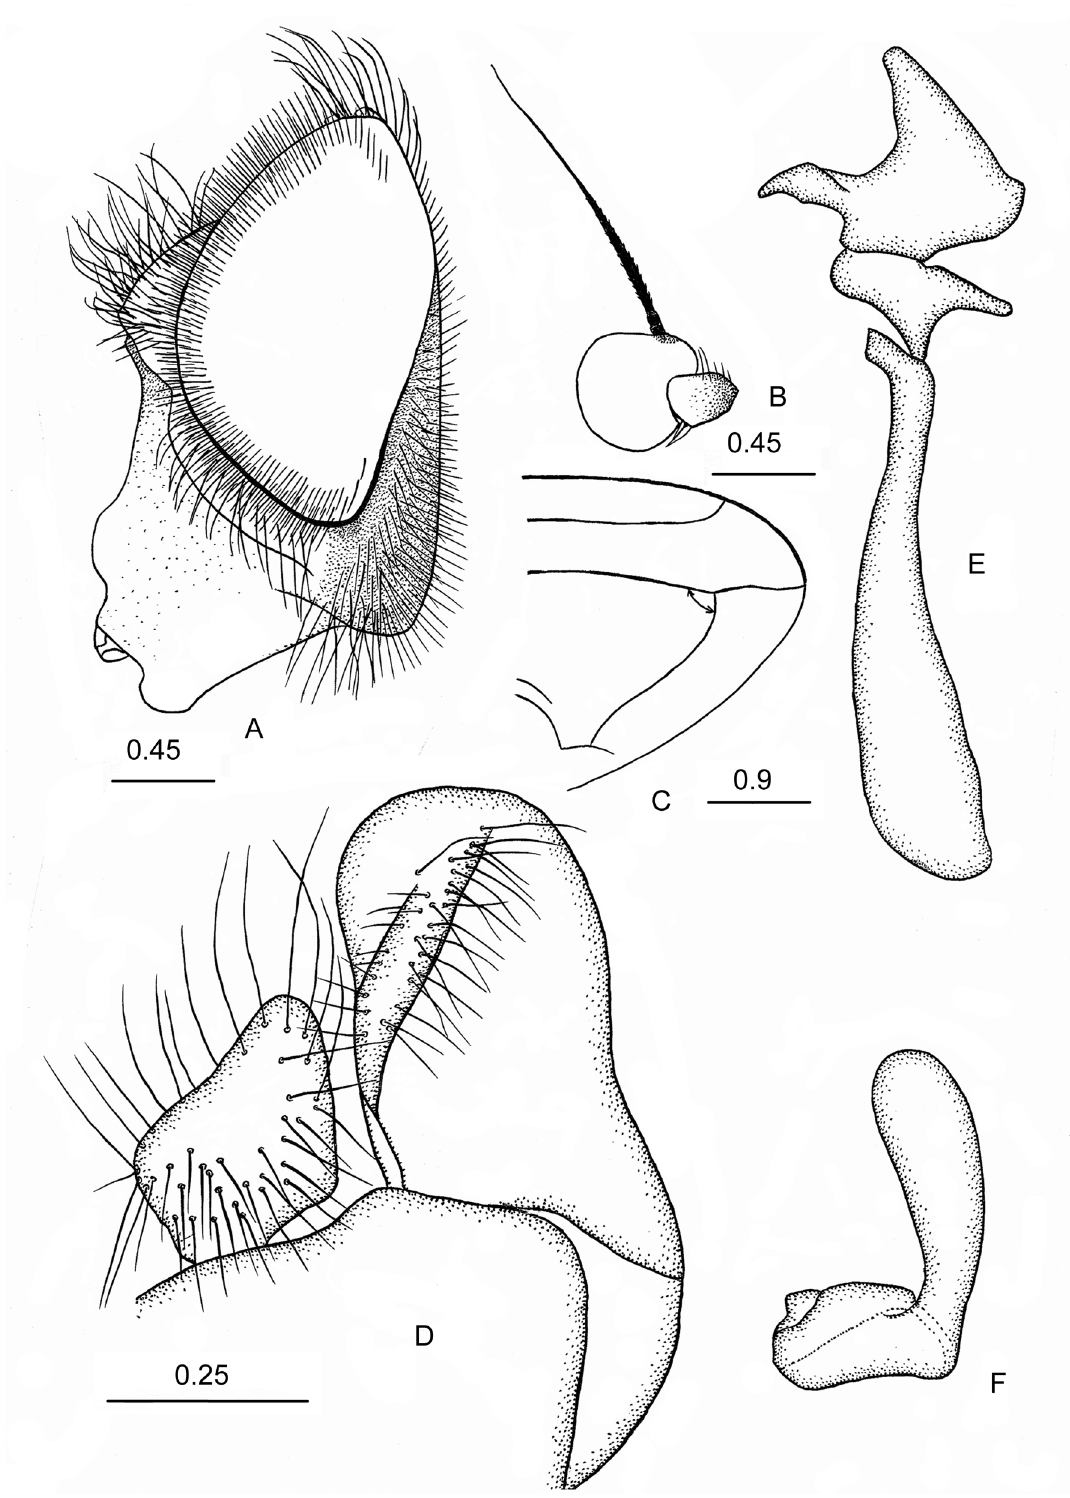
Fig. 11. Cheilosia ( Floccocheila ) crassata sp. nov., holotype, ♂ (ZSMC). A . Head, lateral view. B . Antenna, lateral view of pedicel and basoflagellomere. C . Tip of wing. D . Surstylus and gonocercus, lateral view. E . Aedeagus and aedeagal apodeme, lateral view. F . Superior lobe of hypandrium, lateral view. Scale bars indicated in